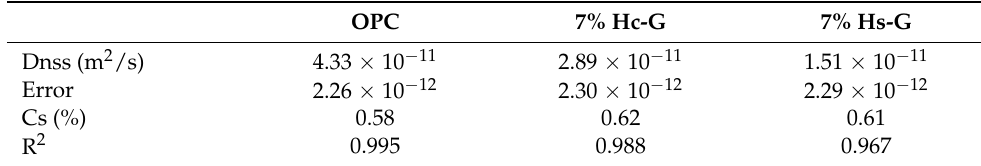
Table 6. Chloride diffusion